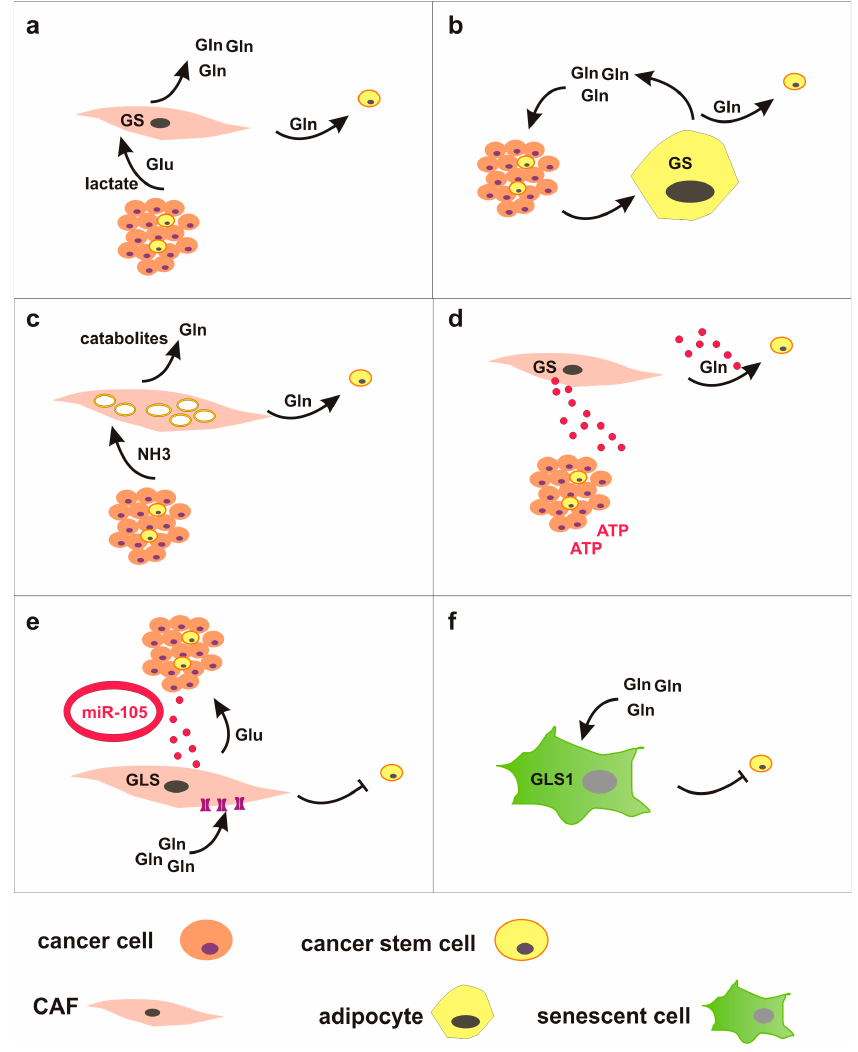
Figure 3. TME components may locally affect glutamine concentration and availability, thereby modulating neighboring CSC. ( a ) Crosstalk between CAF and cancer cells in the TME. CAF upregulate GS and under glutamine-deprived conditions sustain proliferation of glutamine-dependent cancer cells. On the other side, cancer cells release lactate and glutamate to support CAF metabolism. Glutamine produced by CAF might be available for CSC. ( b ) Crosstalk between adipocytes and cancer cells in the TME. High glutamine demand in cancer cells results in glutamine depletion within the TME and induces GS upregulation in dysfunctional cancer-associated adipocytes. Glutamine produced by adipocytes might be available for CSC. ( c ) Crosstalk between CAF and cancer cells in the TME. Ammonia produced by cancer cells selectively induces autophagy in CAF, leading to release of catabolites, including glutamine, which are taken up by cancer cells. Glutamine produced by CAF might be available for CSC. ( d ) Exosomes-mediated crosstalk between CAF and cancer cells in the TME. CAF-derived exosomes contain metabolites, including glutamine, which can be used by cancer cells. Glutamine-containing exosomes produced by CAF might be available for CSC. ( e ) Exosomes-mediated crosstalk between CAF and cancer cells in the TME. Exosome-encapsulated miR-105, released by cancer cells, induces upregulation of GLS and SLC1A5 in CAF. High glutamine demand in CAF can reduce glutamine availability for CSC. ( f ) Senescent cells upregulate GLS1 and rely on glutaminolysis for survival. Senescent cells can avidly uptake glutamine and reduce glutamine availability for CSC.